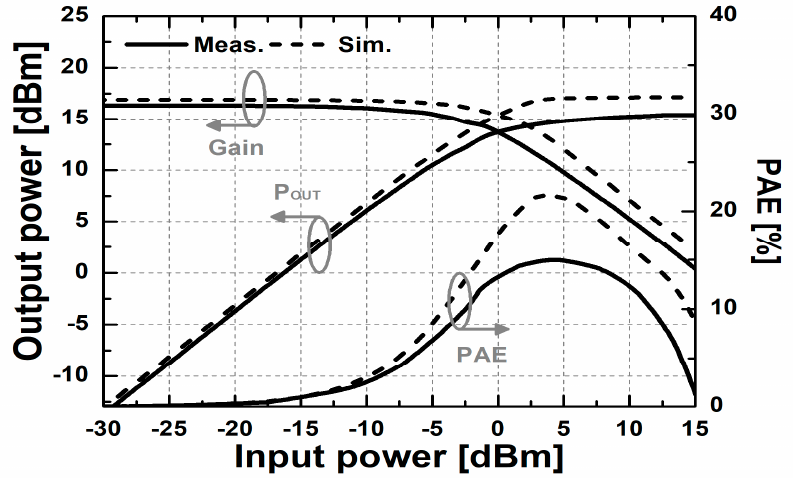
Figure 7. The simulated and measured gain, output power (P OUT ), and power-added efficiency (PAE) of the implemented PA.